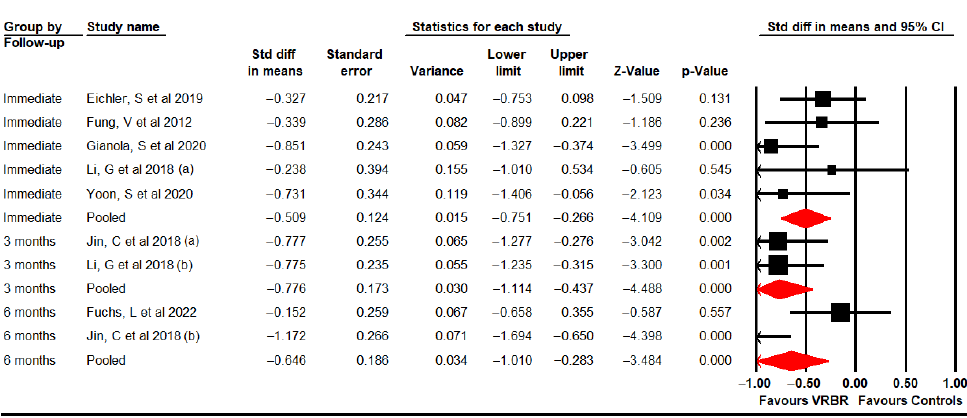
Figure 3. Forest plot of the immediate effect of VRBR on knee function [61–67].